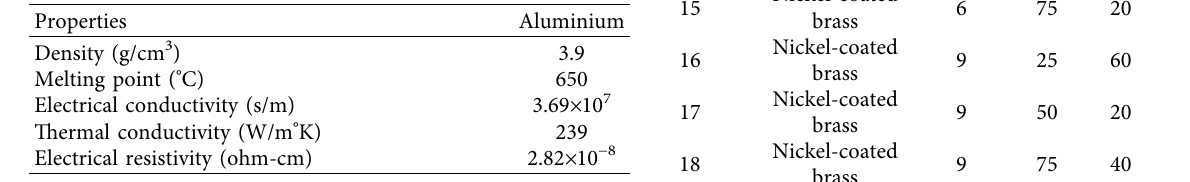
Table 3: Properties of aluminium powder.